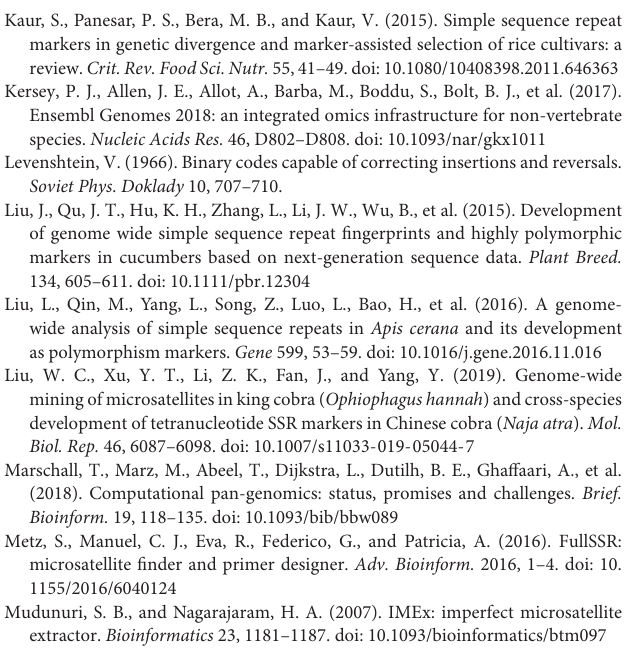
TABLE S1 | Molecular experiments to verify the accuracy of the output by SSRMMD in